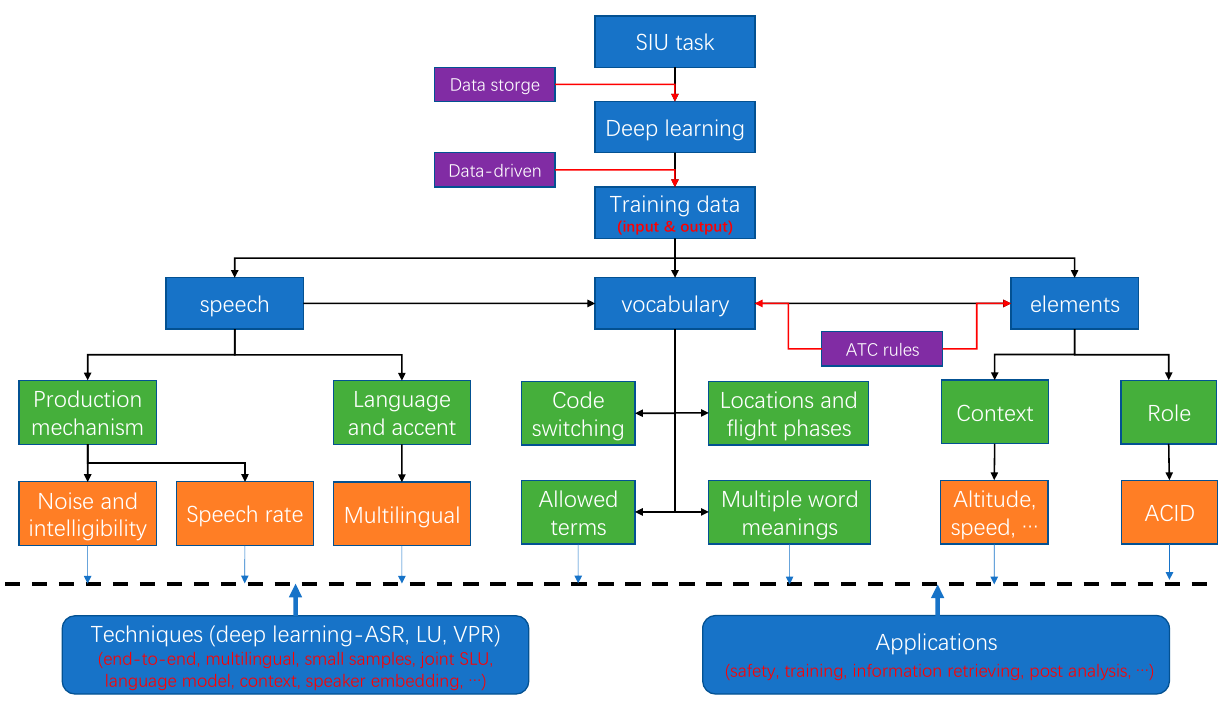
Figure 2. Research design in this work.